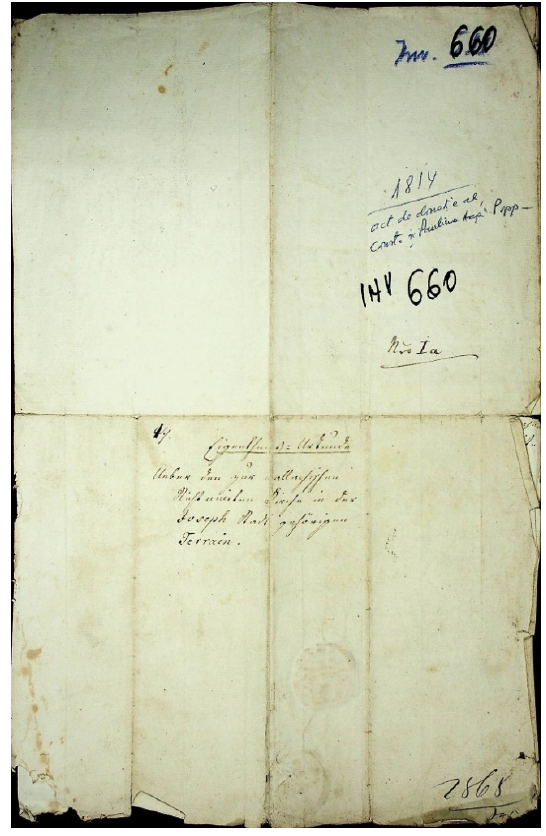
Figure 4. Last page of the document (page 4).